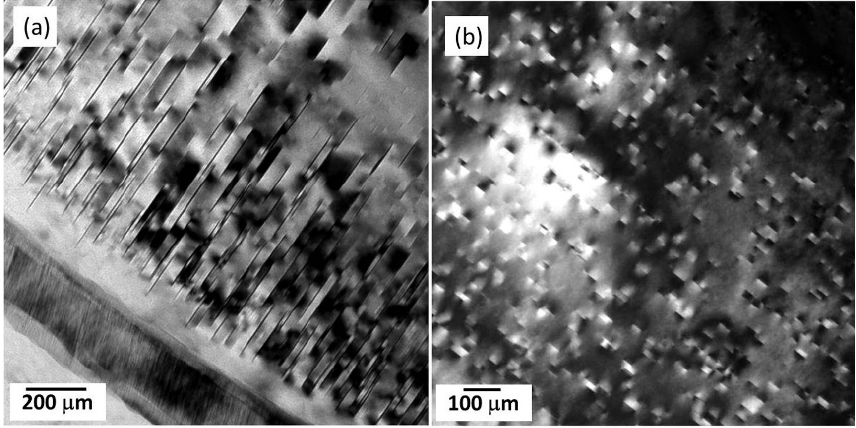
Figure 14. ( a , b ) TEM images showing fine plate-like precipitates in the heat-treated AEX422 alloys [118].